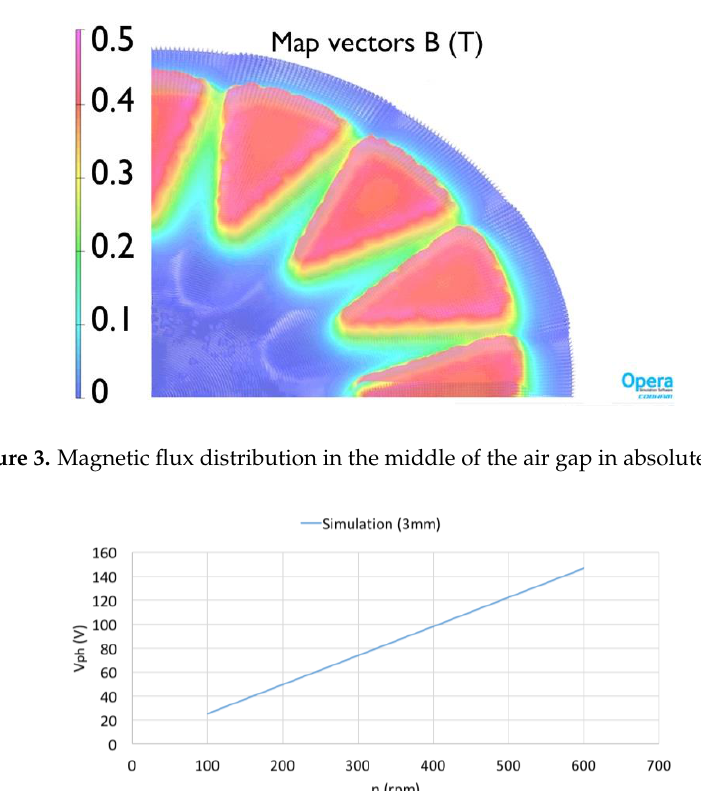
Figure 2. 3D simulated model (exploded preview).